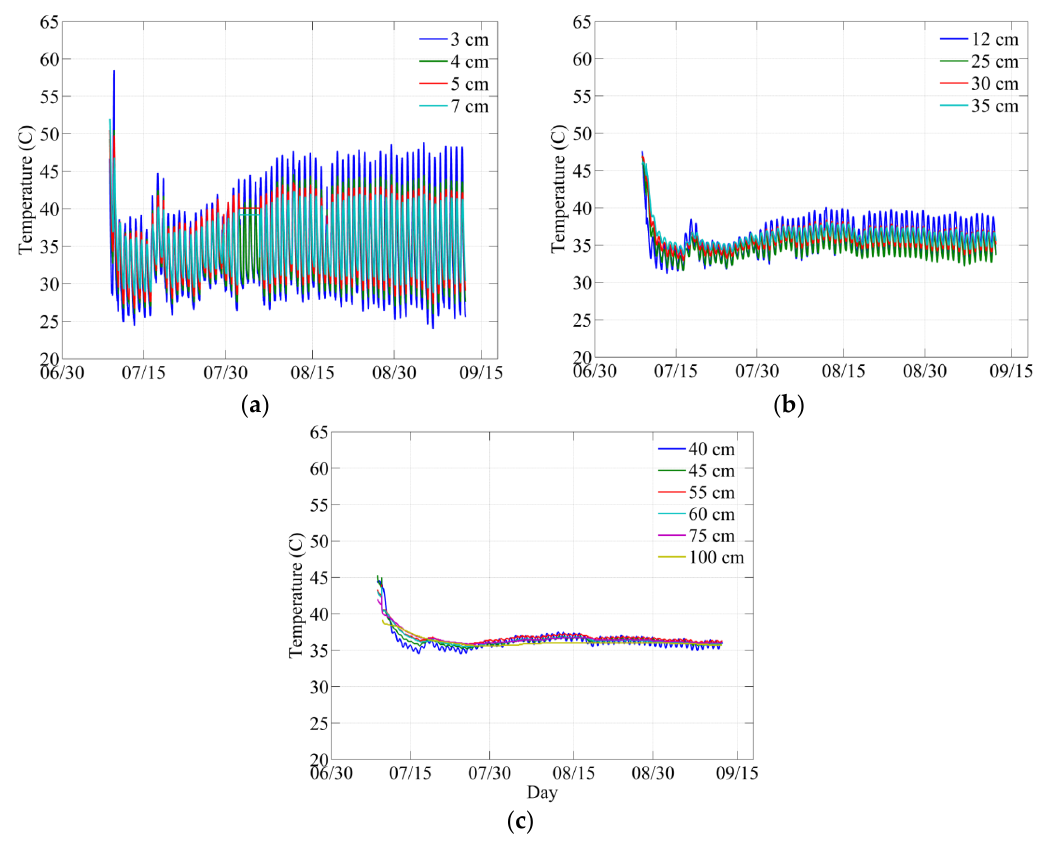
Figure 7. Temperature fluctuations recorded by the sensors ( a ) from depths of 3–7 cm; ( b ) from depths of 12–35 cm; and ( c ) from depths of 40–100 cm.